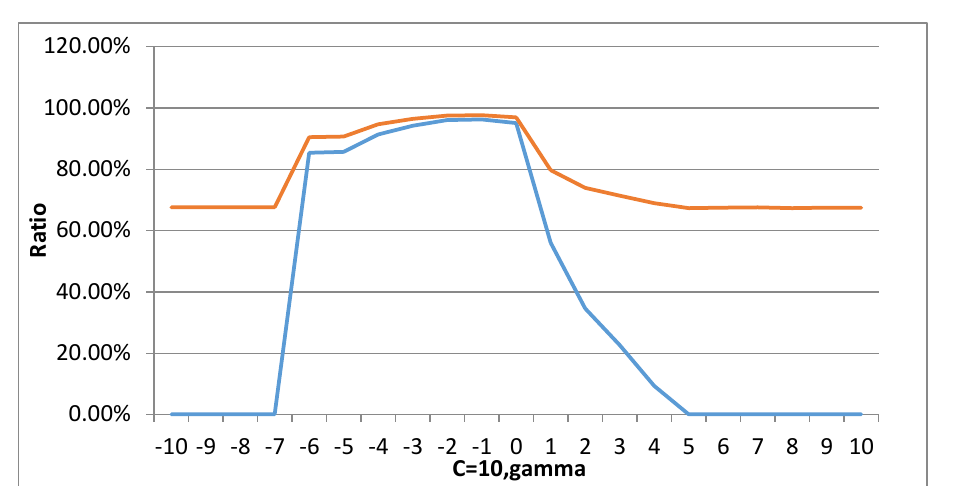
Figure 7. Variation curve of metrics with gamma at C = 10. (The red curve represents accuracy, while the blue curve represents the F value).